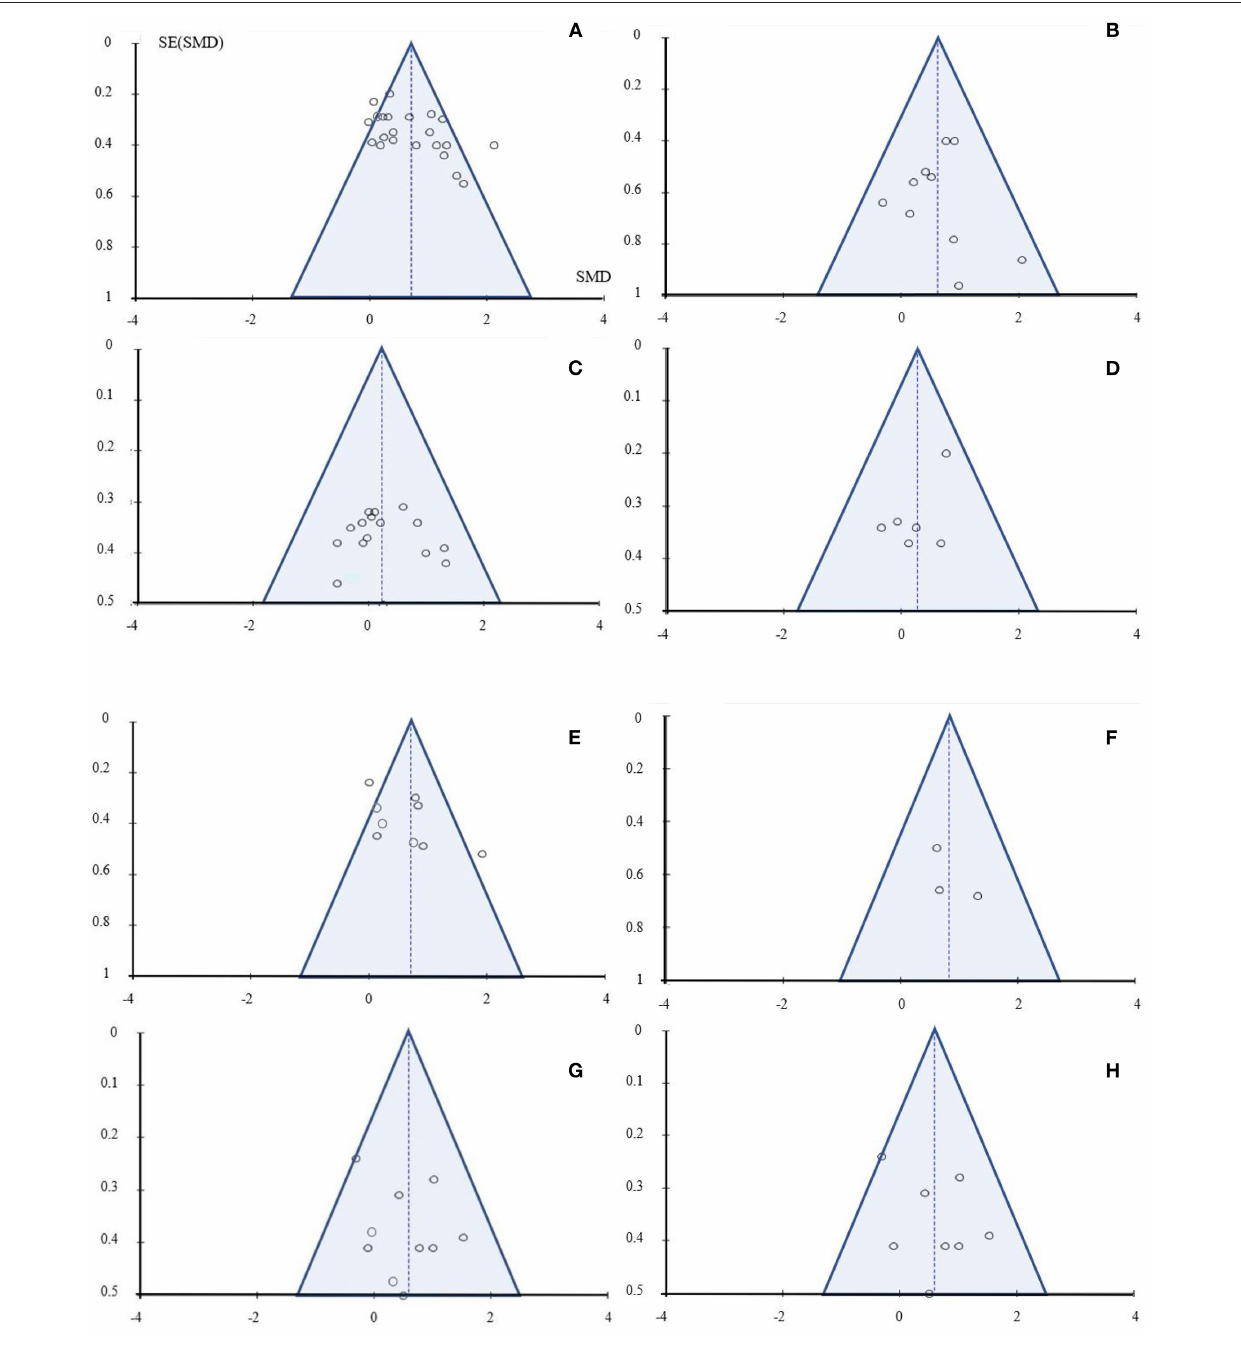
(quality of life, pain, and health perception), large and significant effects were evident [ p < 0.001, SMD: 0.83 (95% CI: 0.42, 1.24), l 2 =